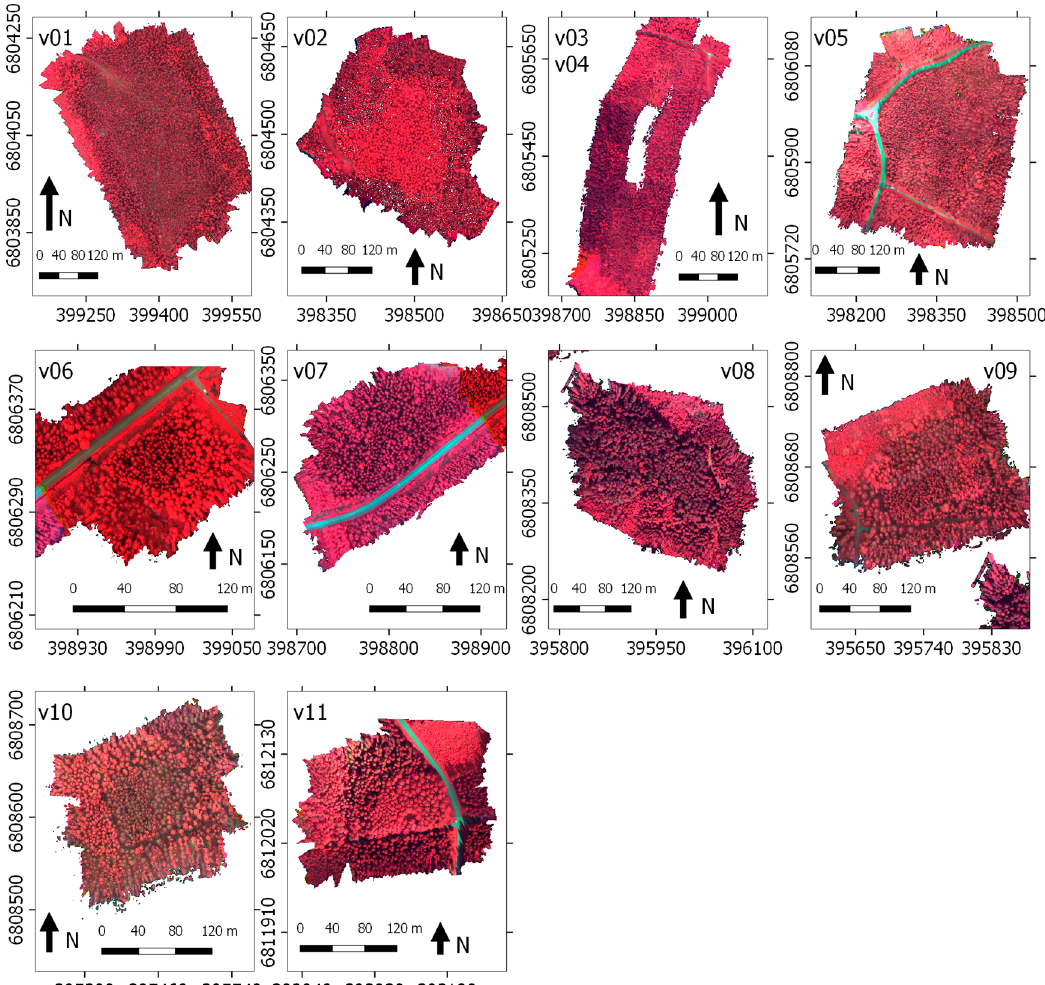
Figure 7. Hyperspectral image mosaics of the test sites. The spectral values have been optimized for visual purposes, and the scaling is not the same for all